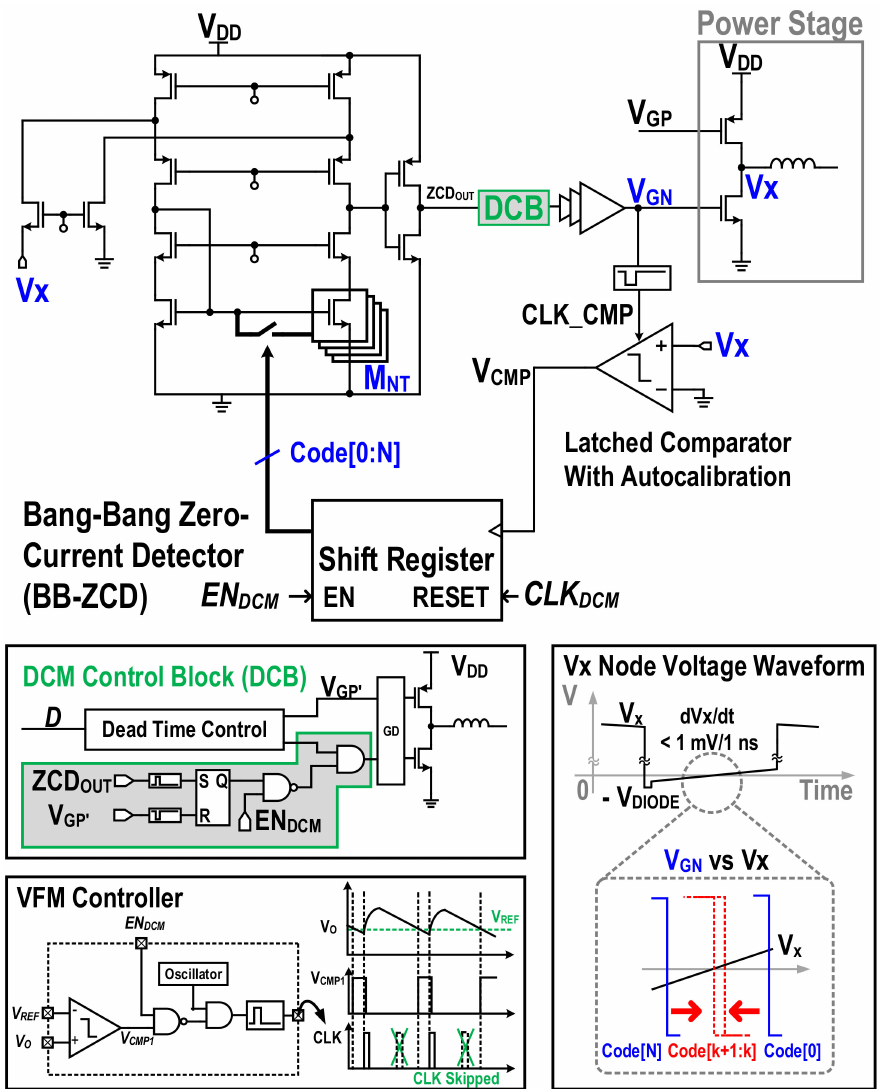
Figure 8. Proposed the bang-bang zero current detector (BB-ZCD) and discontinuous conduction mode (DCM)